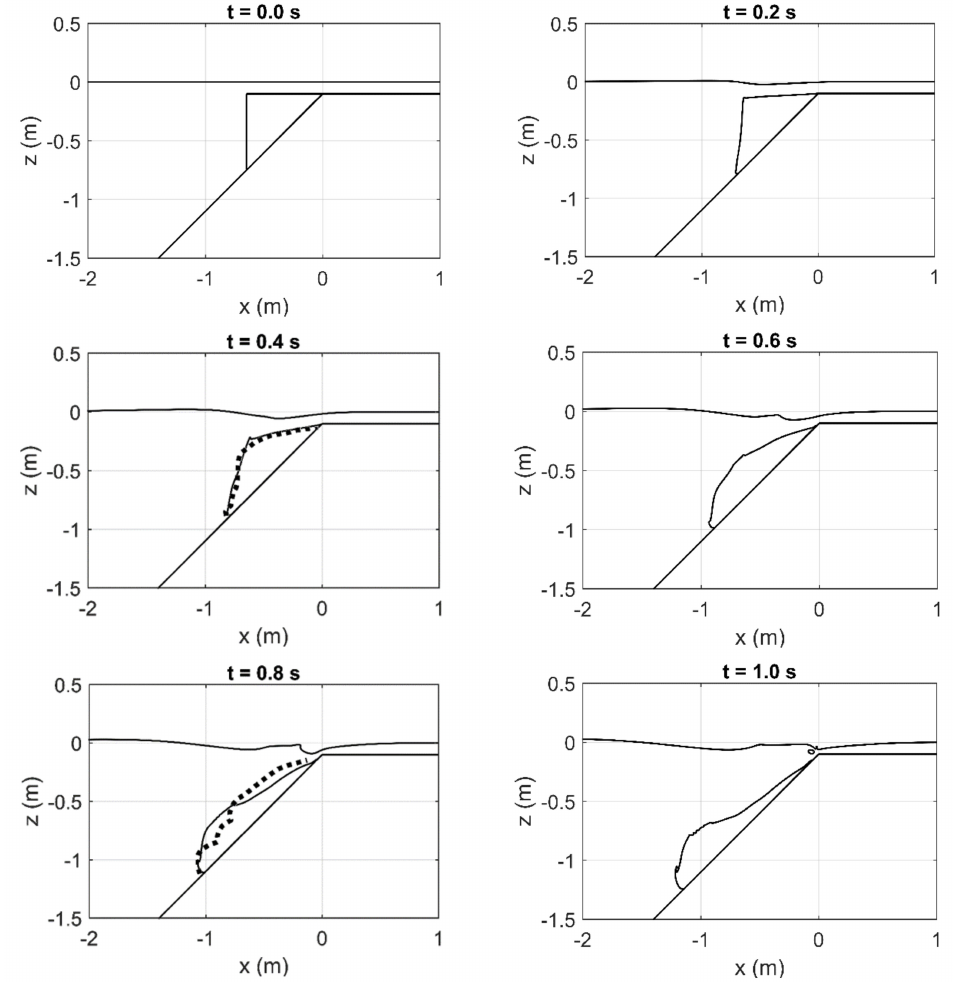
Figure 2. The distributions of free-surface profiles and slump profiles at t = 0.0 s ~ t = 1.0 s. The solid lines are the numerical results and the dot lines are the experiment